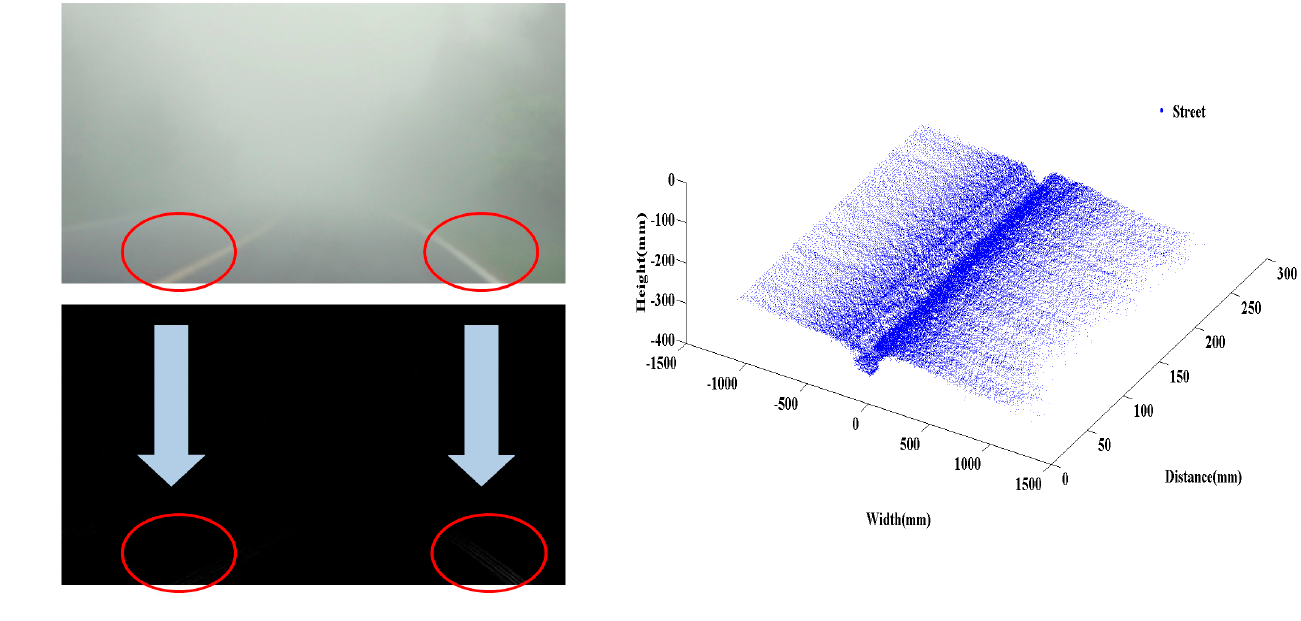
Figure 11. Lane detection using vision in foggy weather.